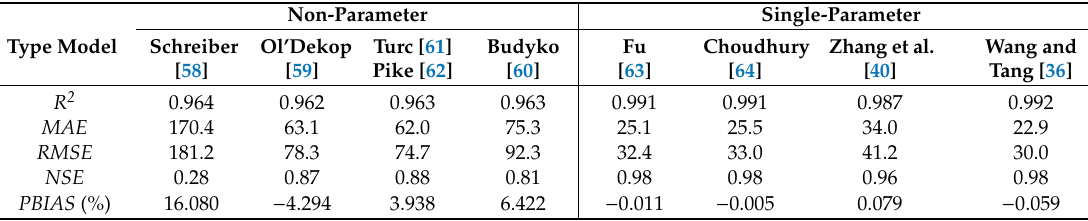
Table 5. Statistical performance analysis indices of each